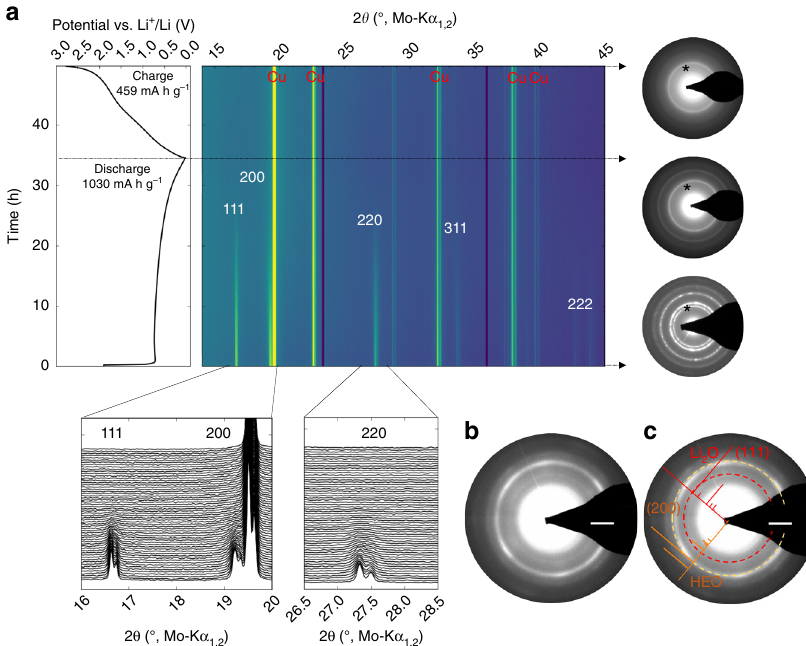
Fig. 3 Operando XRD on TM-HEO. a XRD results obtained during the fi rst full lithiation/delithiation cycle. The black lines with arrows indicate the as- prepared, fully lithiated and fully delithiated states as a function of time, with the corresponding potential curve shown on the left side. The XRD re fl ections fade with lithiation over the fi rst few hours and, after the fi rst full cycle, the re fl ections are not visible anymore. In the SAED patterns on the right side, crystallites, much smaller than the starting size, are still visible due to the shorter wavelength of the electrons. The asterisk indicates the (200) lattice plane of the rock-salt structure, which is maintained during the entire process. The presence of a very faint SAED ring in the lithiated samples in b and c (d-spacing 2.68 Å, scalebars 2 1/nm) could be attributed to the (111) diffraction of Li 2 O. From the combined XRD and TEM results, it can be concluded that the rock-salt structure is preserved during cycling and serves as a host matrix for the redox processes. Unreacted TM-HEO can be ruled out since otherwise, the corresponding diffraction spots should be visible in the SAED and the XRD re fl ections should not disappear completely. Supplementary Figure 10 shows an SAED pattern obtained on an electrode after 10 full cycles, still showing the rock-salt structure. The voltage pro fi le seen for the operando XRD measurement is plotted versus the dis/charge time. The fi rst cycle discharge capacity amounts to around 1030 mAh g ‒ 1 , which corresponds to an uptake of roughly 2 Li per formula unit. The initial charge capacity is lower, being 459 mAh g ‒